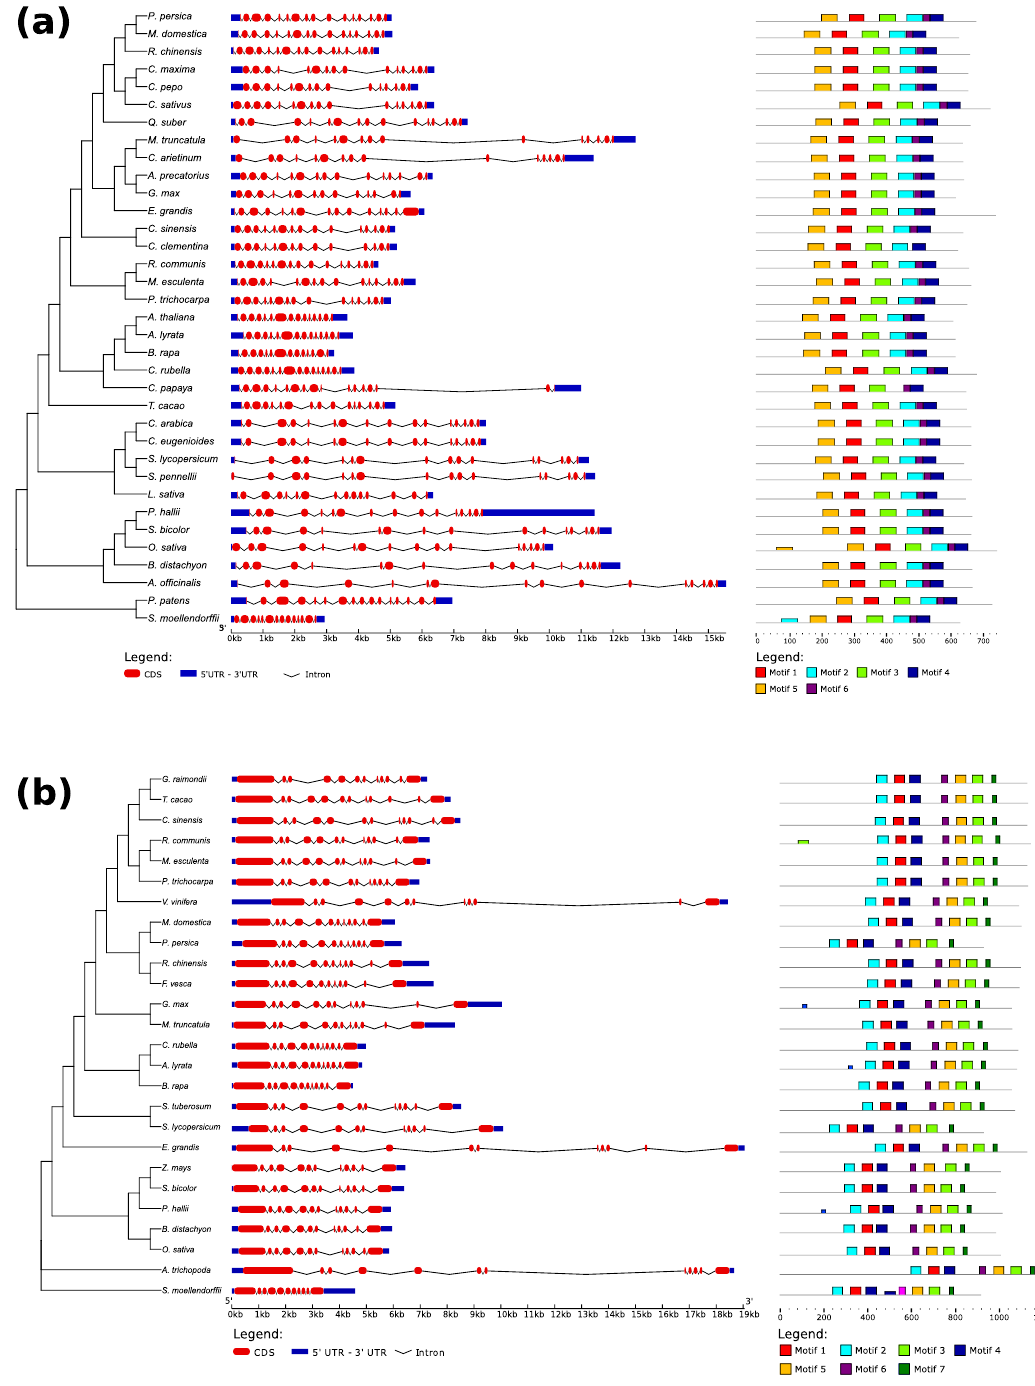
Figure 3. Gene and protein structure of selected ( a ) TDP1 α and ( b ) TDP1 β sequences. In the gene structure (central part of the figure), UTRs are represented as blue boxes, introns as black lines, and exons as blue round boxes. The colored boxes in the right part of the figure are recurring motifs found with MEME5.0 in the protein sequences (Tables S4 and S5). Lower boxes represent lower confidence. The phylogenetic tree on the left is the same as in Figure 1, trimmed for a selected subset of